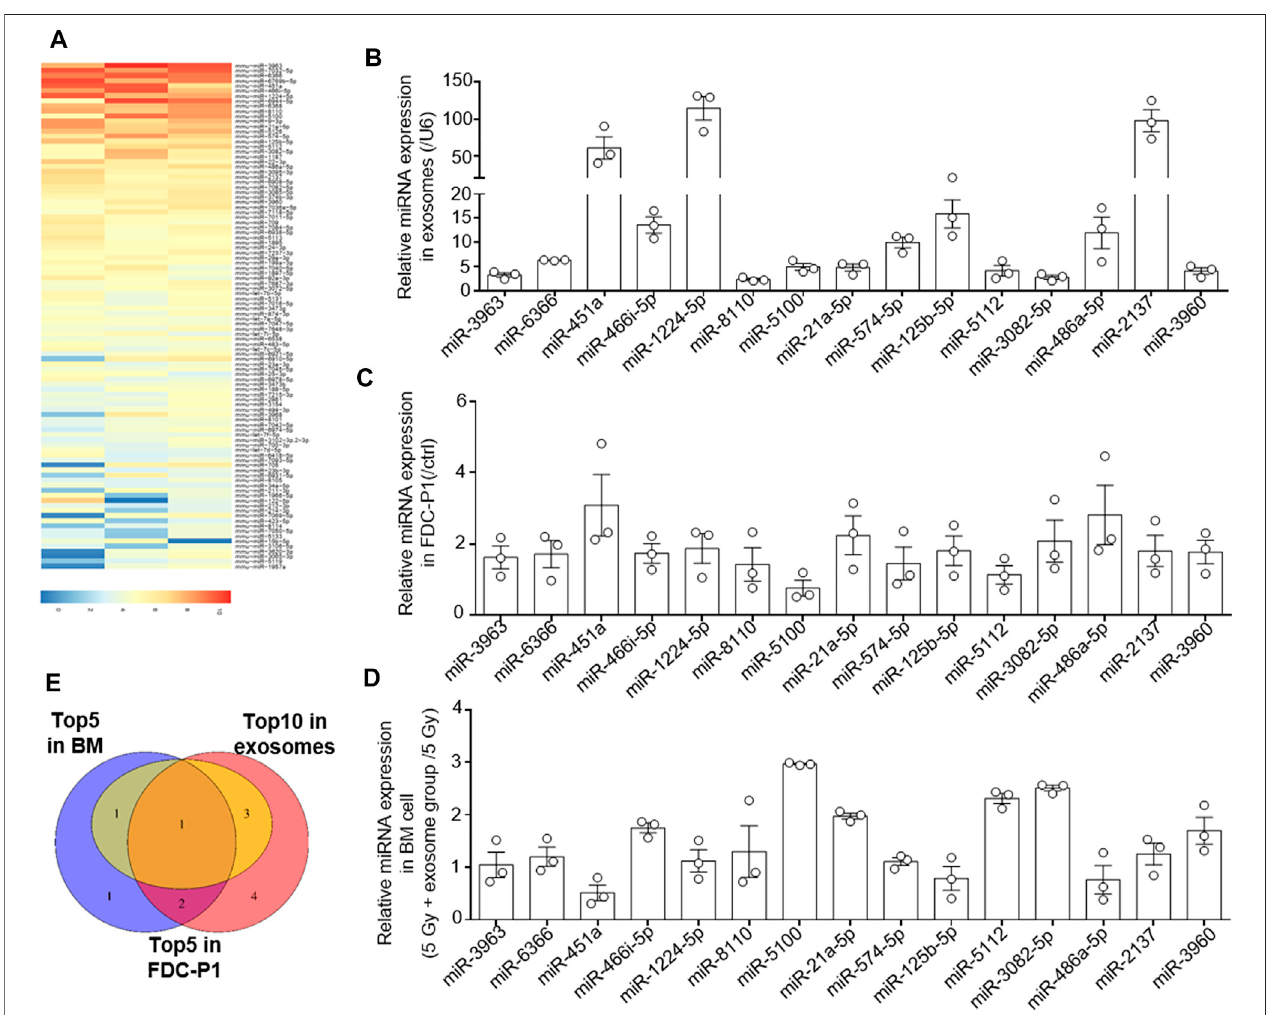
FIGURE4| TheosteoblastderivedexosomesmiRNAanalysis. (A) TheheatmapofmiRNAinOB-exosomes,theredcolorrepresentshighmiRNAexpressionlevel, andthebluecolorrepresentslowmiRNAexpressionlevel. (B) qRT-PCRanalysisofexpressionofmiRNAlevelsinOB-exosomes. (C) qRT-PCRanalysisofexpressionof miRNA levels in FDC-P1 treated with or without OB-exosomes for 6 h. The relative expression of miR-21 was normalized to U6. (D) qRT-PCR analysis of expression of miRNA levels in bone marrow cells of irradiated mice injected with or without OB-exosomes. (mean ± sem, n = 3). (E) Venn diagram of top 10 miRNA in OB- exosomes, top 5 miRNA in FDC-P1 and top 5 miRNA in bone marrow.